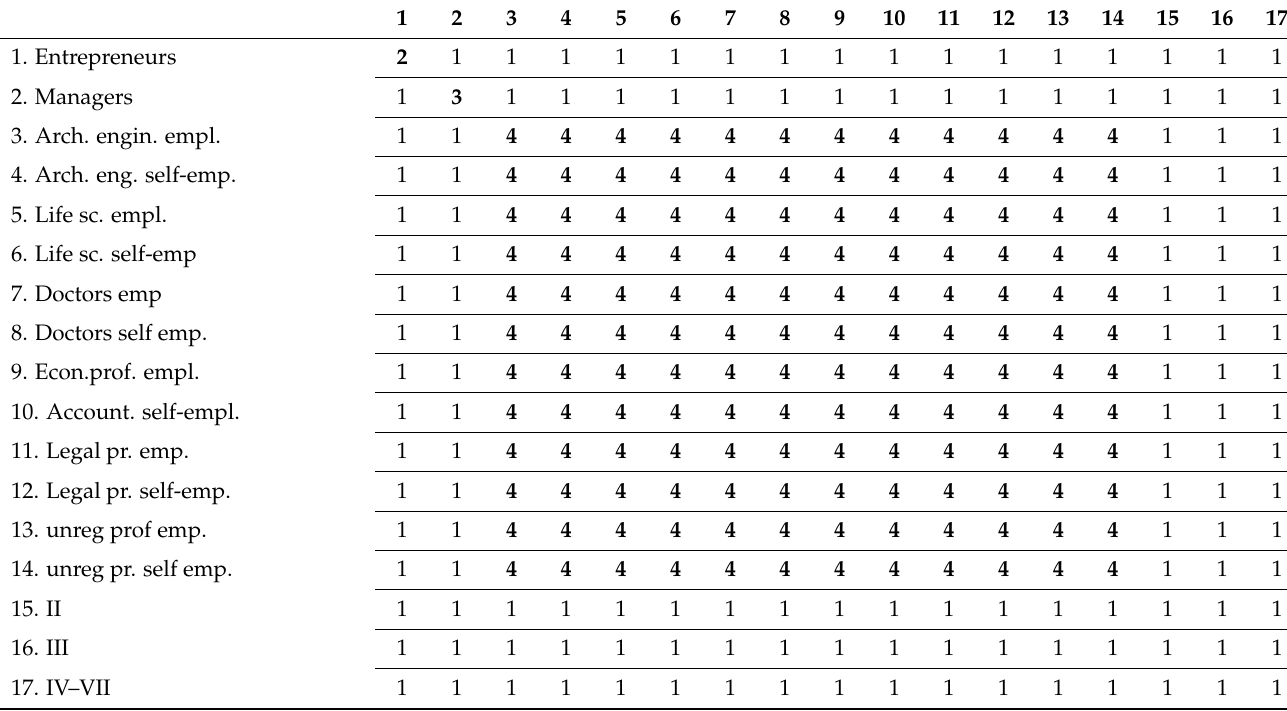
Table A2. Meso-class rigidities—Model 2a and 2b.